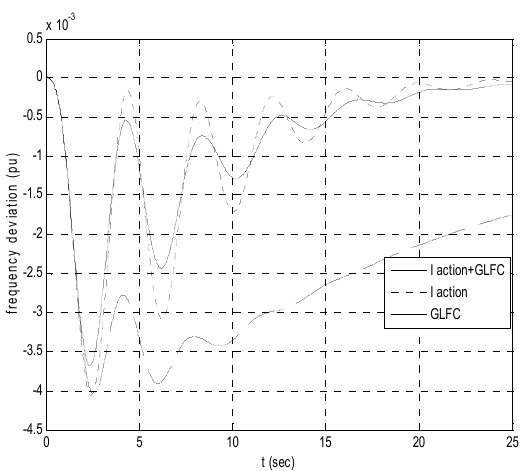
Designs 2019 , 3 , x FOR PEER REVIEW